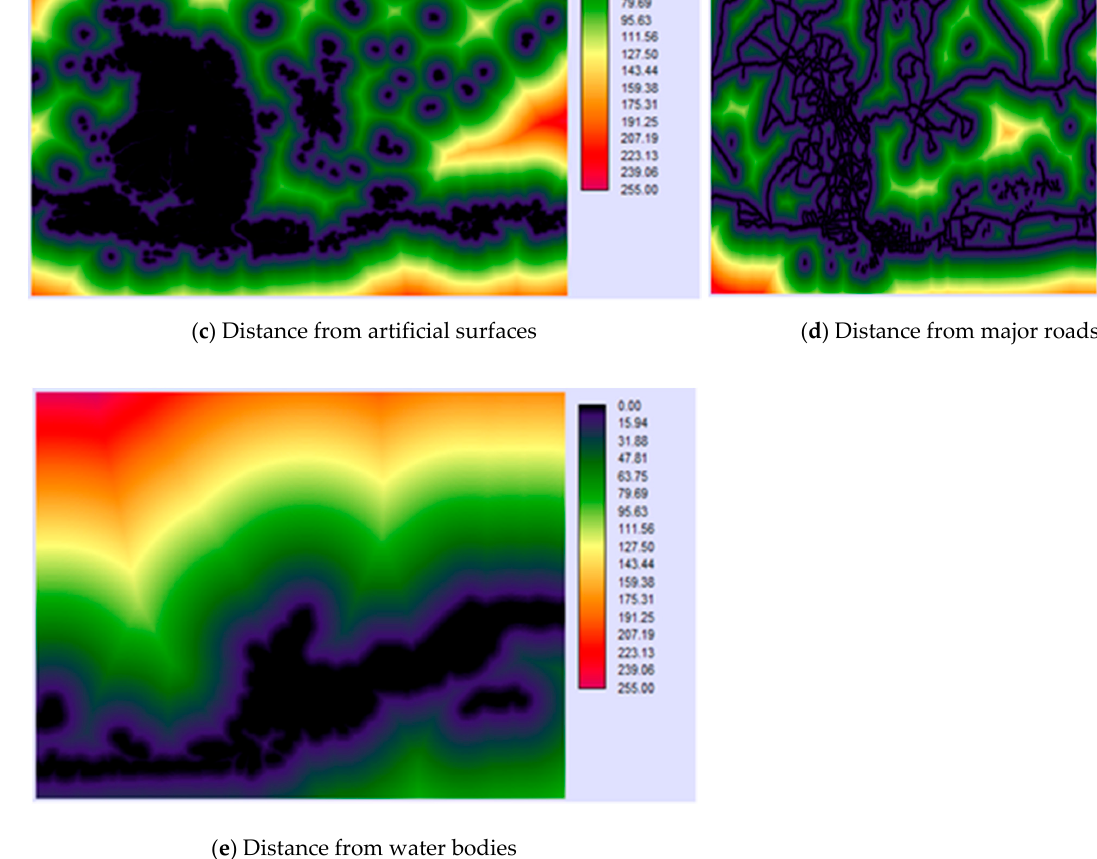
Figure 5. Standardized factors (variables) used in the study: ( a ) Elevation, ( b ) slope, ( c ) distance from artificial surfaces, ( d ) distance from major roads, and ( e ) distance from water bodies.